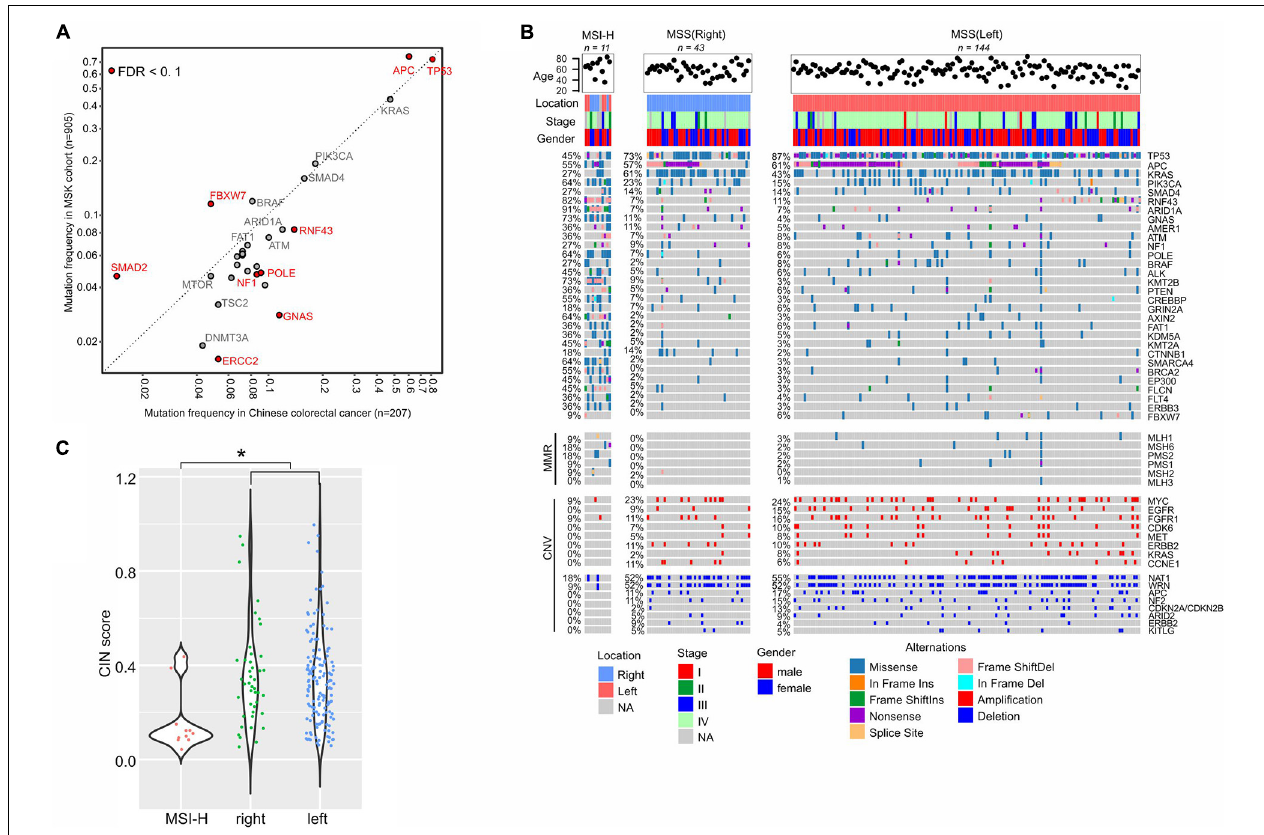
FIGURE 4 | Molecular characterization of colorectal cancer. (A) Mutation frequency comparison between our cohort and the MSKCC colorectal cancer cohort. (B) Gene alterations in the sub-groups of colorectal cancers. (C) CIN status in different sub-groups. Dunn’s multiple comparison test is used to compare CIN values between every two groups and * means p <